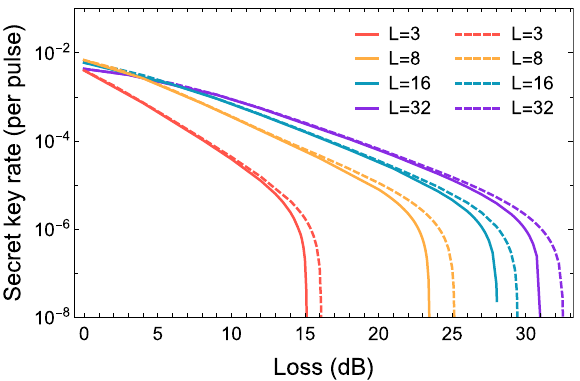
Fig. 1 Secret key rate R versus channel loss. The full lines show the secret key rate R versus channel loss for the RRDPS protocol when N em is fi nite. From left to right, L is 3, 8, 16, 32, and the corresponding total emitted pulses are 2 × 10 9 , 10 10 , 4 × 10 10 , 6 × 10 10 , respectively. While the dashed lines represent the asymptotic results correspond to ref. 10 . The total security parameter of fi nal key is ϵ tot : = 10 − 10 . Dark counts rate is d = 10 − 6 per pulse, and the misalignment of measurement is e mis = 0.015. The ef fi ciency of error correction ξ is